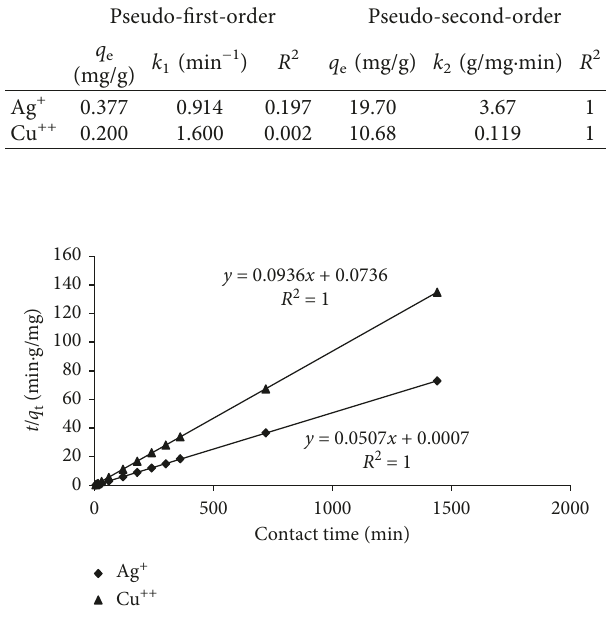
Figure 3: Pseudo-second-order adsorption kinetics of Ag + and Cu ++ on the clay surface.